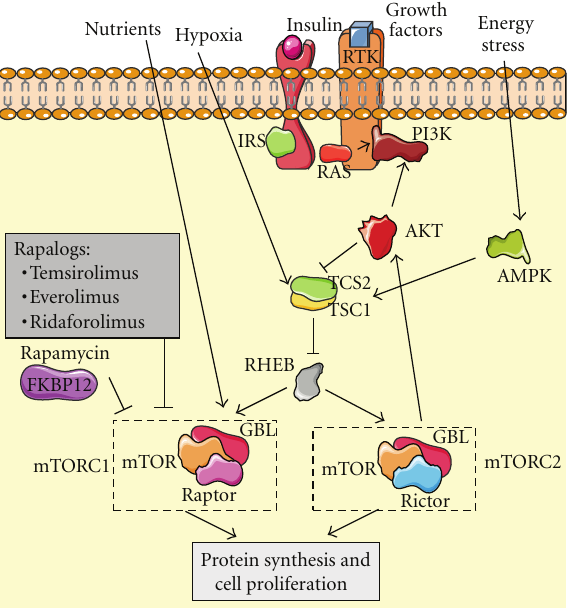
Figure 3: AKT activation, among other stimulus, can activate mTOR complexes, mTORC1 and mTORC2, promoting protein synthesis and cell proliferation. Rapamycin and rapalogs are specific inhibitors of mTORC1 but an escape route remains through mTORC2 activity.